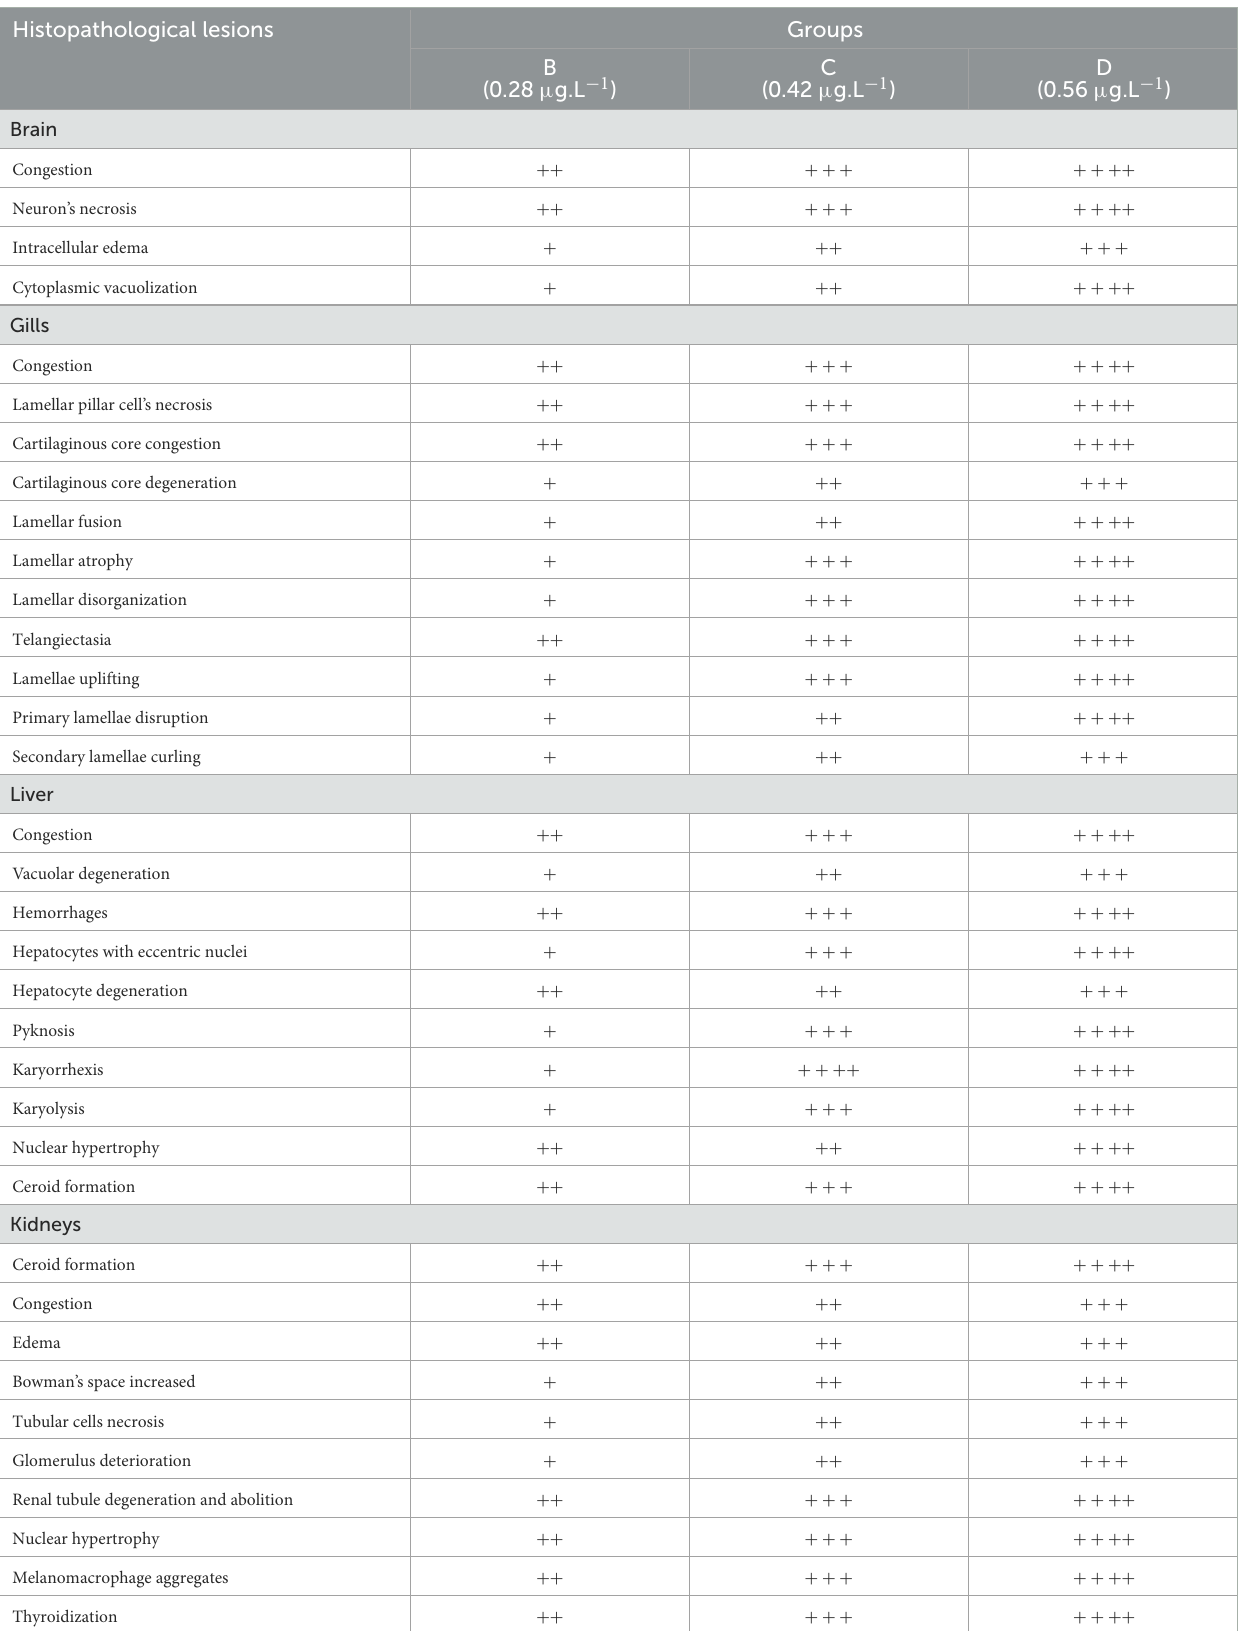
TABLE 7 Severity/degree of different histopathological lesions in various organs/tissues of Labeo rohita treated to various concentrations of copper sulfate at 12th day. Histopathological lesions